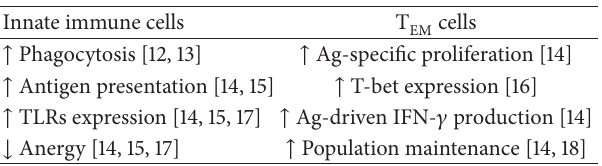
Table 1: Effects of IFN- 𝛾 priming on innate immune cells and T EM cells. The table summarizes the effects of IFN- 𝛾 priming on innate immune cells and on T EM cells. The references relative to each function induced by priming are in